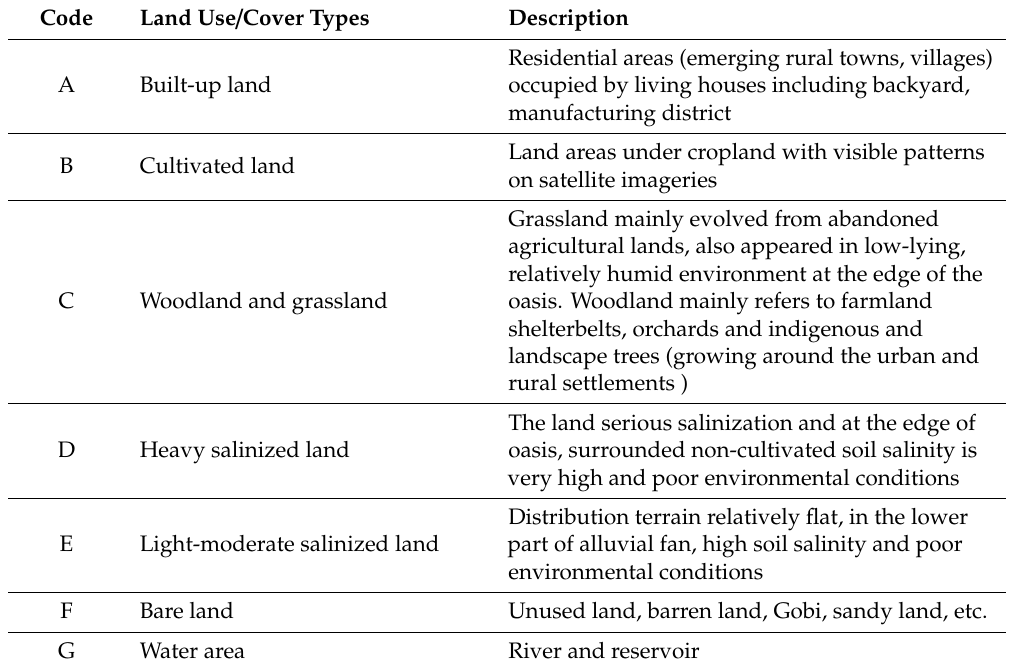
Table 1. Description of land use and land cover (LULC) classes used to measure the changes in periods 1990 to